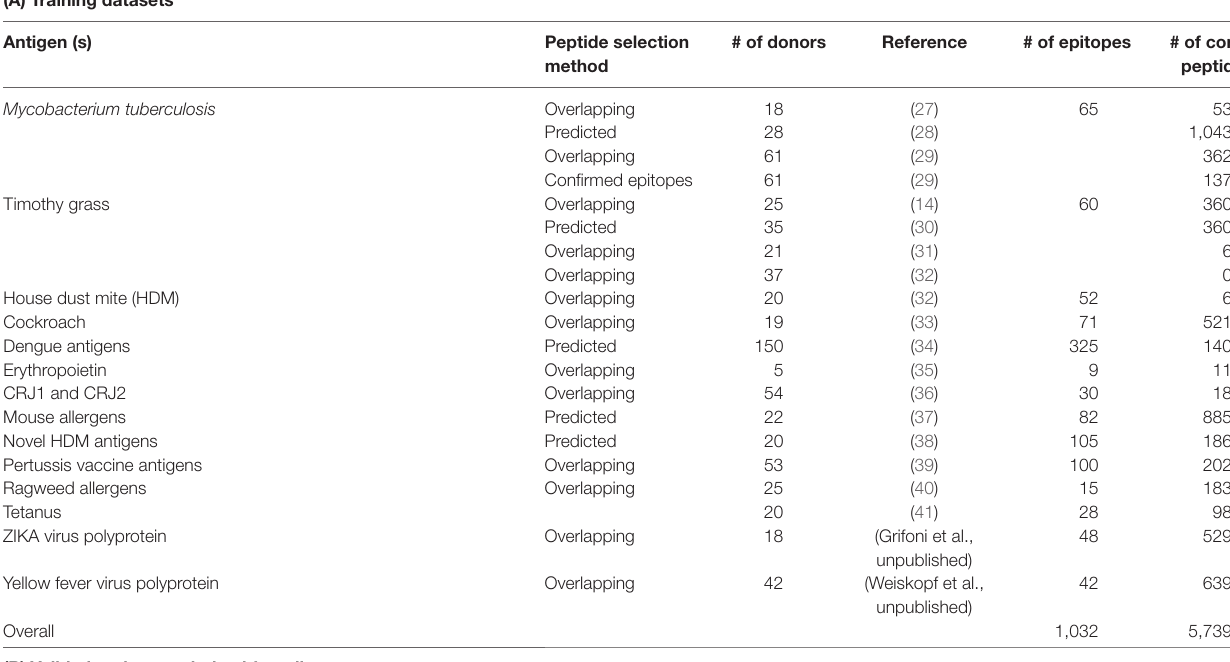
TaBle 1 | Full list of datasets used in this